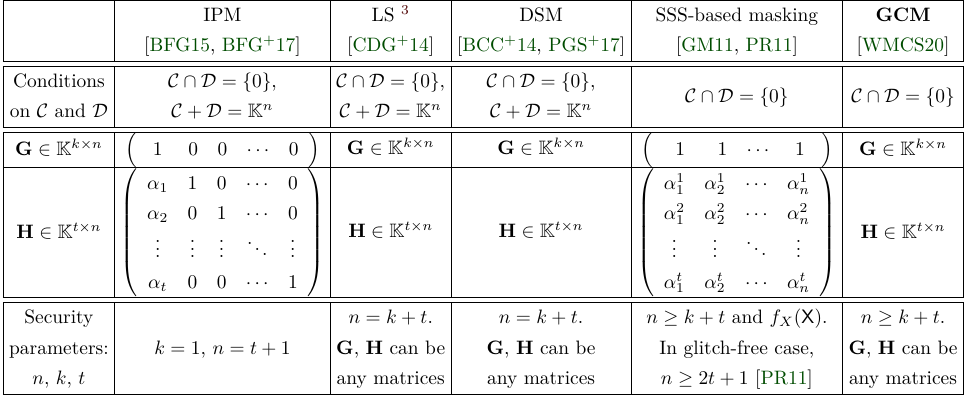
Table 1: Encodings in IPM, LS, DSM, SSS-based masking and GCM,